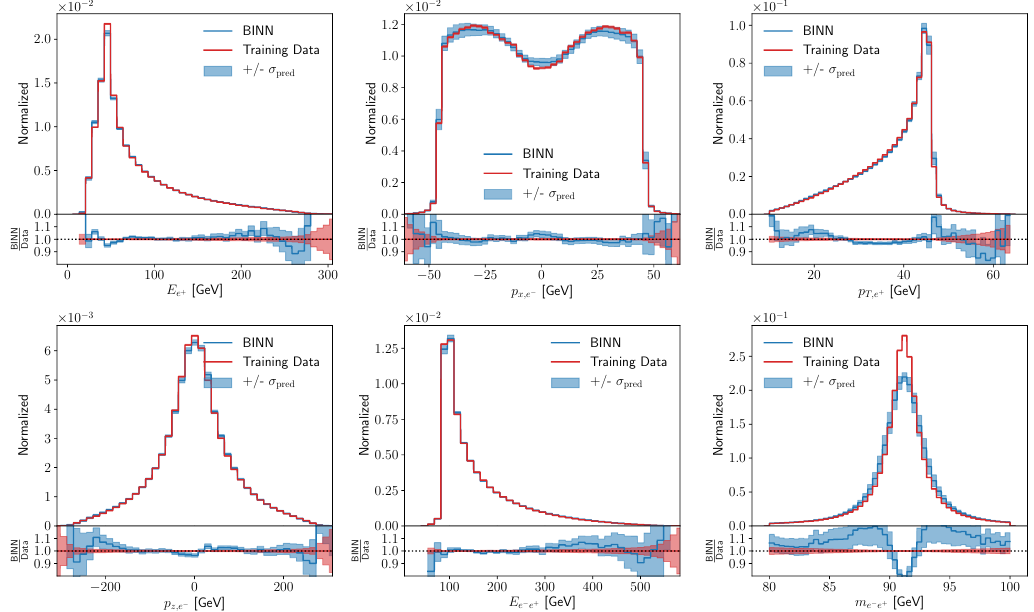
Figure 9: One-dimensional (marginalized) kinematic distributions for the Drell-Yan process. We show the central prediction from the BINN and include the predictive uncertainty from the BINN as the blue band. The red band indicates the statistical uncertainty of the training data per bin in the Gaussian